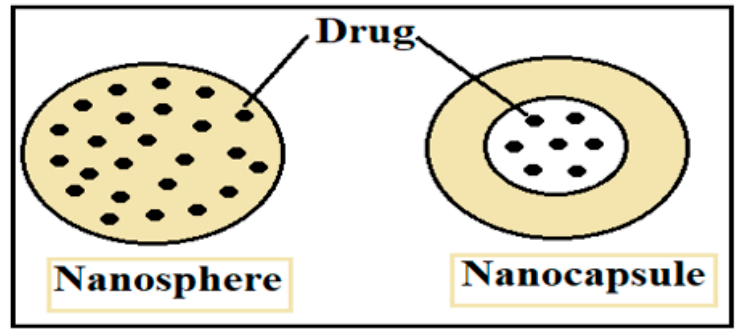
Figure 1. Schematic of nanomedicines: nanospheres and nanocapsules.